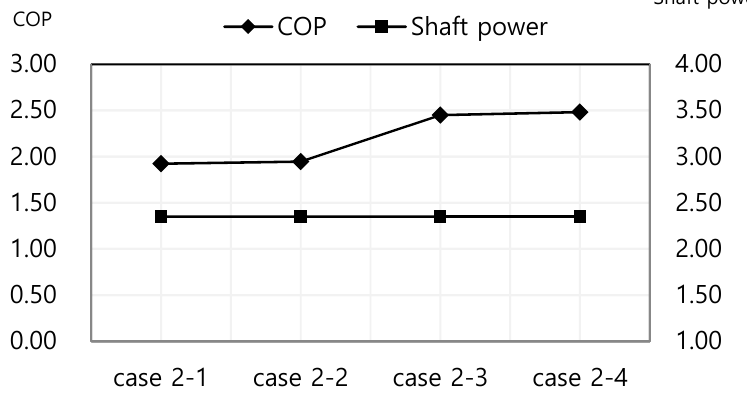
Figure 9. Changes in the axial power of the air blower and COP with the internal form change.